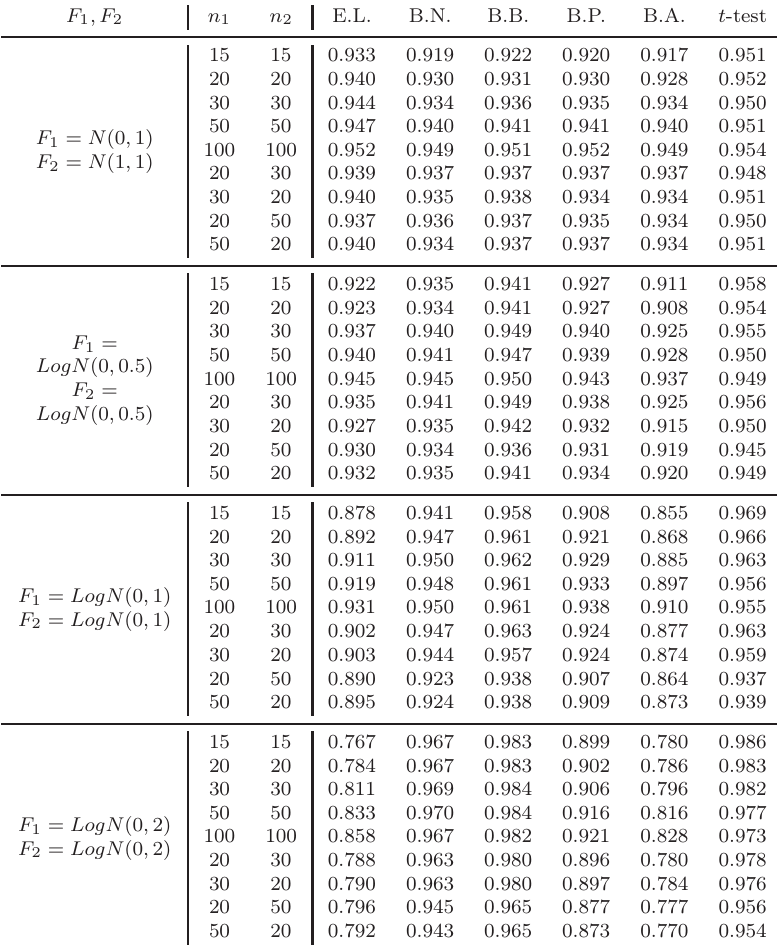
Table 1. 95% coverage accuracies for two-sample mean differences µ 2 − µ 1 , comparing. Empirical likelihood (E.L.), two–sample t -test, four bootstrap methods (B.N. – normal bootstrap; B.B. – basic bootstrap; B.P. – percentile bootstrap; B.A. – bias–corrected bootstrap). The coverage accuracies are based on 10,000 pseudorandom samples from F 1 and F 2 for each combination of sample sizes n 1 and n 2